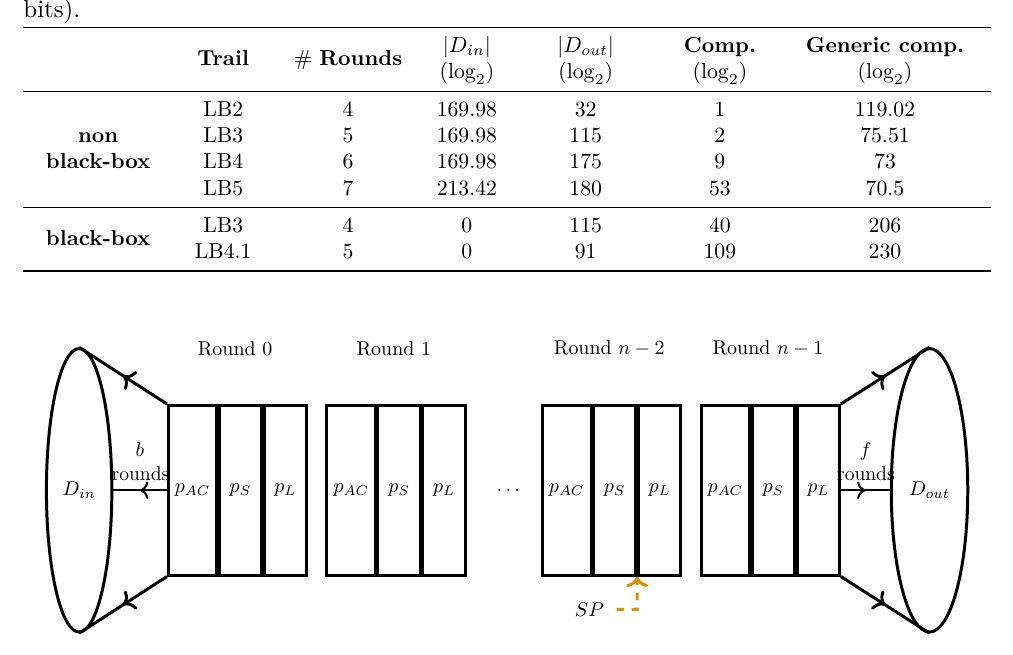
Figure 3: An illustration of how we construct our non-black-box limited-birthday: after obtaining a differential characteristic, we allow it to spread backward and forward by b and f rounds respectively with probability 1. SP indicates the starting point of our limited-birthday